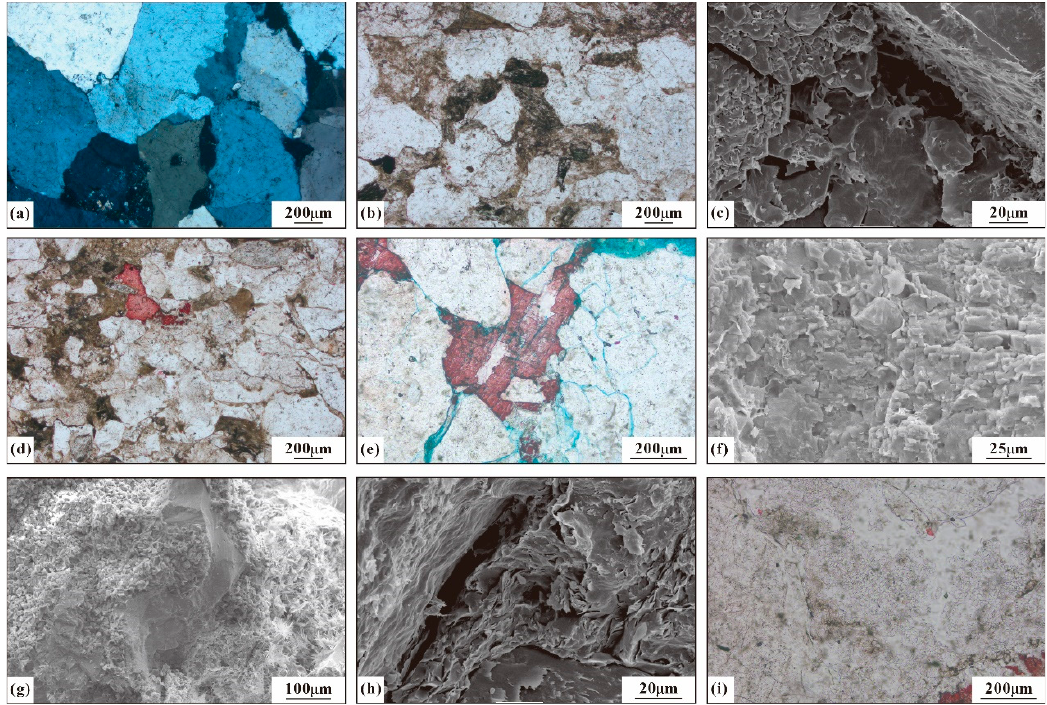
Figure 5. Microscopic characteristics of typical diagenesis of the Lower Shihezi Formation tight sandstones in Duguijiahan block, Ordos Basin: ( a ) well J126, 2901 m, strong compaction results in the close arrangement of clastic particles, cpl; ( b ) well J108, 3143.7 m, argillaceous cement, ppl; ( c ) well J112, 3058.9 m, secondary enlargement of quartz particles with intergranular dissolution pores, SEM; ( d ) well J113, 3069.3 m, argillaceous cement and calcite cement, ppl; ( e ) well J57, 2990 m, intercrystalline dissolution pores in calcite, ppl; ( f ) well J95, 3117.08 m, feldspar particles is slightly dissolved, and filamentous illite filled between particles, SEM; ( g ) well J103, 3072.94 m, the edges of the particles are slightly dissolved, and the particles are filled with filamentous illite, illite–smectite mixed layer, and kaolinite, SEM; ( h ) well J108, 3153.32 m, the flaked kaolinite is dissolved, and there are dissolution micro pores between clastic particles, SEM; and ( i ) well J110, 3030.5 m, kaolinite cement, ppl. Abbreviations: ppl: plane-polarized light; cpl: cross-polarized